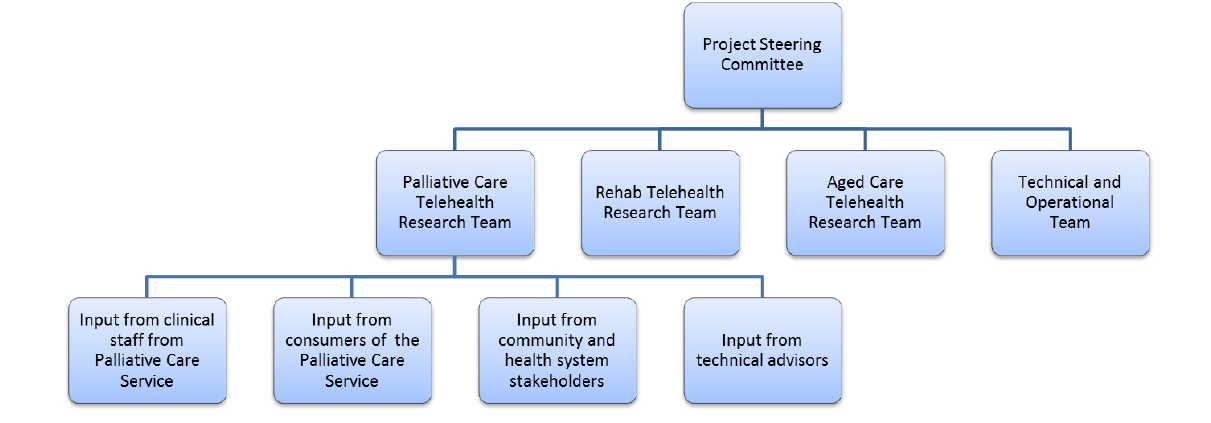
Figure 1. Overview of governance relationship and avenues for project input.